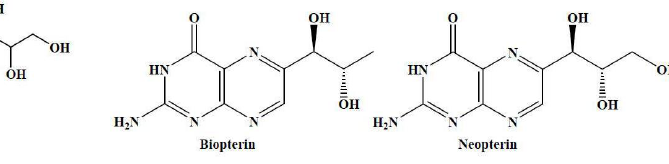
Figure 4: Non-redox active natural pterins.